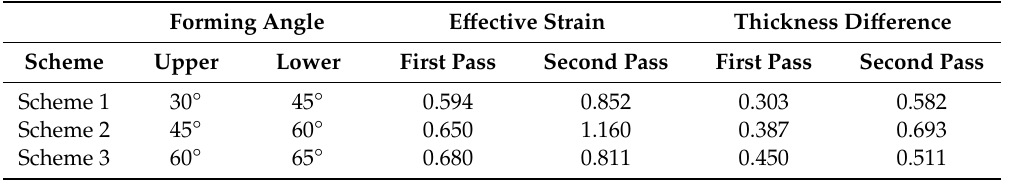
Table 6. Simulation results based on di ff erent forming